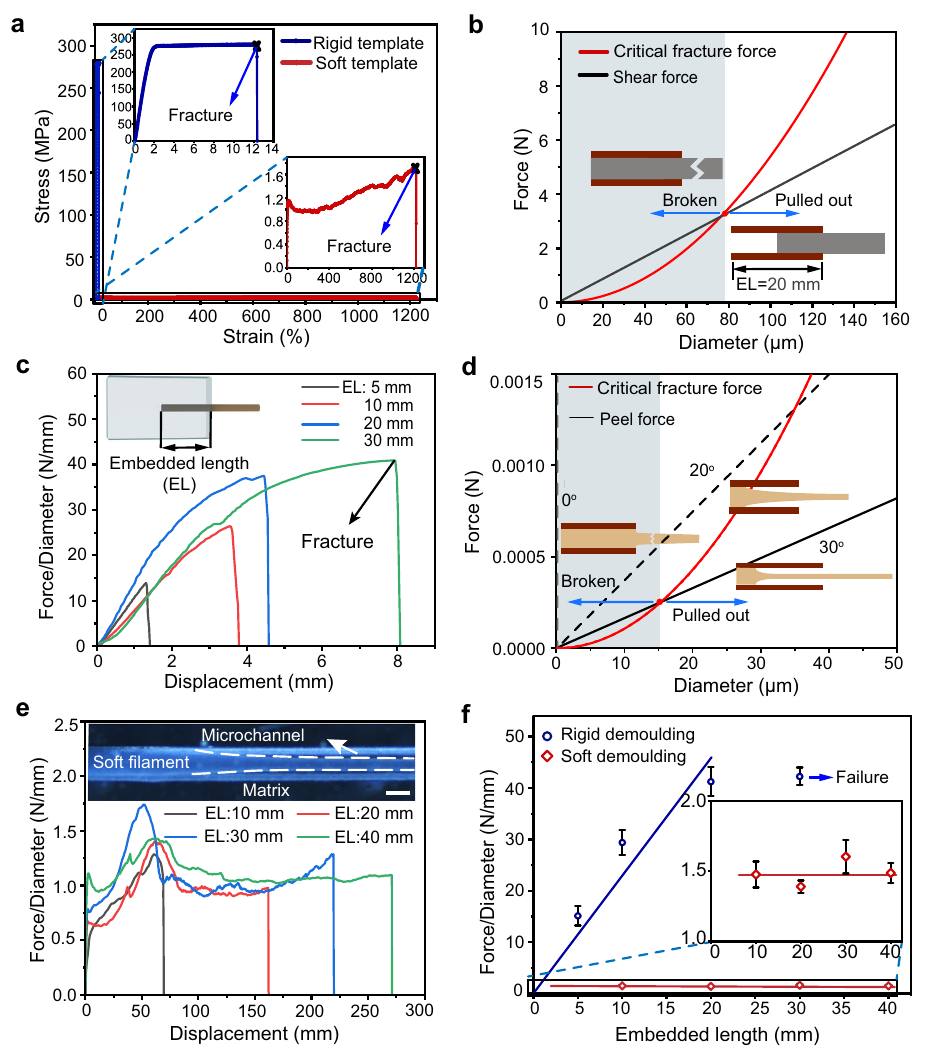
Fig. 3 | Mechanisms of soft demoulding and rigid demoulding. a The stress- strain curvatures of a rigid template (copper) and a soft template (thermoplastic resin). b The critical fracture force and shear force of the rigid template (copper wire with 20mm embedded length) for different fi lament diameters. The shadow region represents the range of the demoulding failure. c The force/ diameter – displacement curve with different embedded lengths (EL) for rigid templates (copper). The diameter of the copper wire is 80 μ m. d The critical fracture force and peel force varying with the diameter of soft template